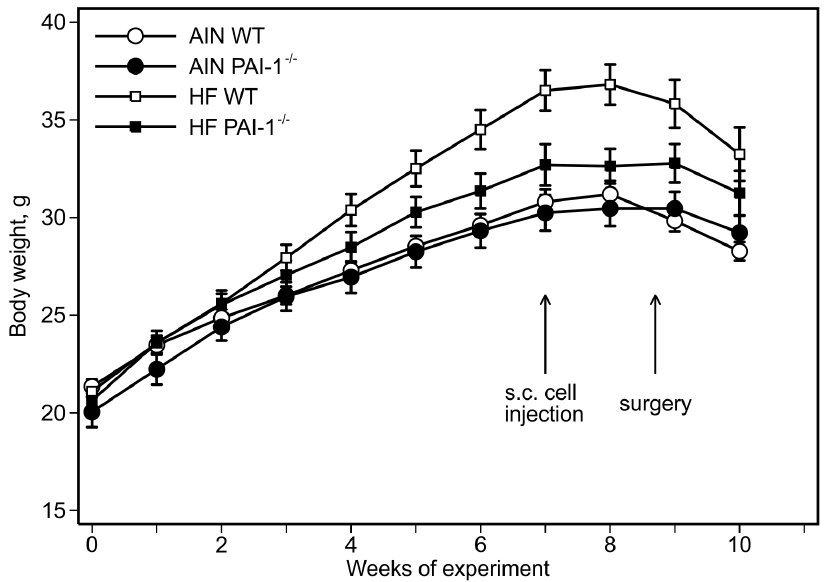
Figure 1. Body weight. Two-way ANOVA and Tukey contrasts were performed to test for differences among the groups. The high-fat diet, compared to the AIN93G diet, increased body weights; the difference was significant starting 4 weeks after the initiation of experimental feeding ( p , 0.01), and the significant increase continued throughout the experiment. Compared to wild-type mice, PAI-1 deficiency lowered body weights, and the difference was significant starting at week 6 of the experiment ( p # 0.05). Values are means 6 SEM (n=11 per group for PAI-1 2 / 2 mice, n=14 per group for wild-type mice; second cohort). AIN WT: AIN93G-fed wild-type mice, AIN PAI-1 2 / 2 : AIN93G-fed PAI-1 2 / 2 mice, HF WT: high-fat fed wild-type mice, HF PAI-1 2 / 2 : high-fat fed PAI-1 2 / 2